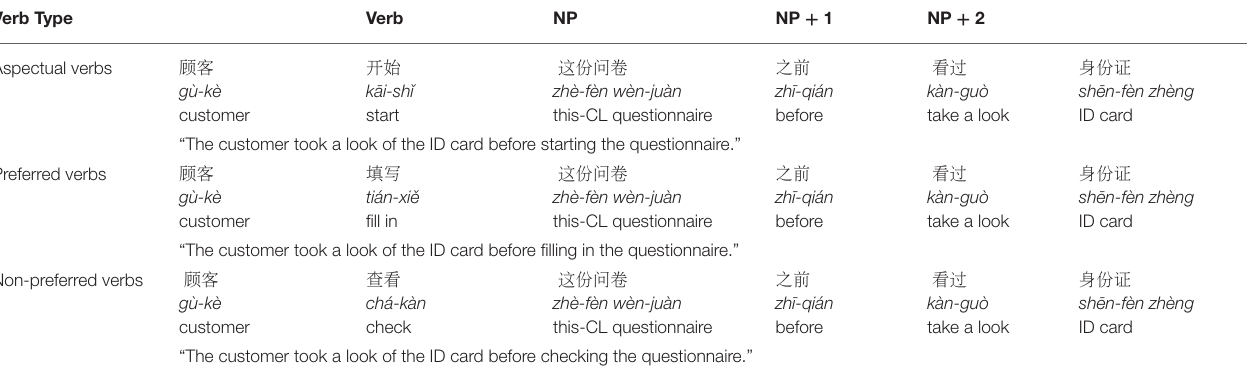
TABLE 1 | A samples set of